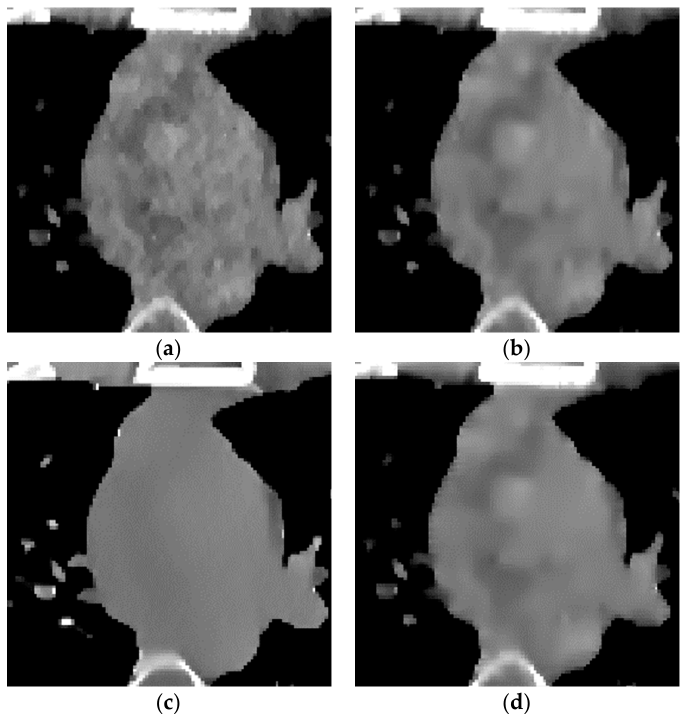
Figure 11. Enlarged local results of incident photon number 5 × 10 3 . ( a ) EP iterative reconstruction; ( b ) DCT image post-processing; ( c ) DL iterative reconstruction algorithm; ( d ) learning sparse transform.